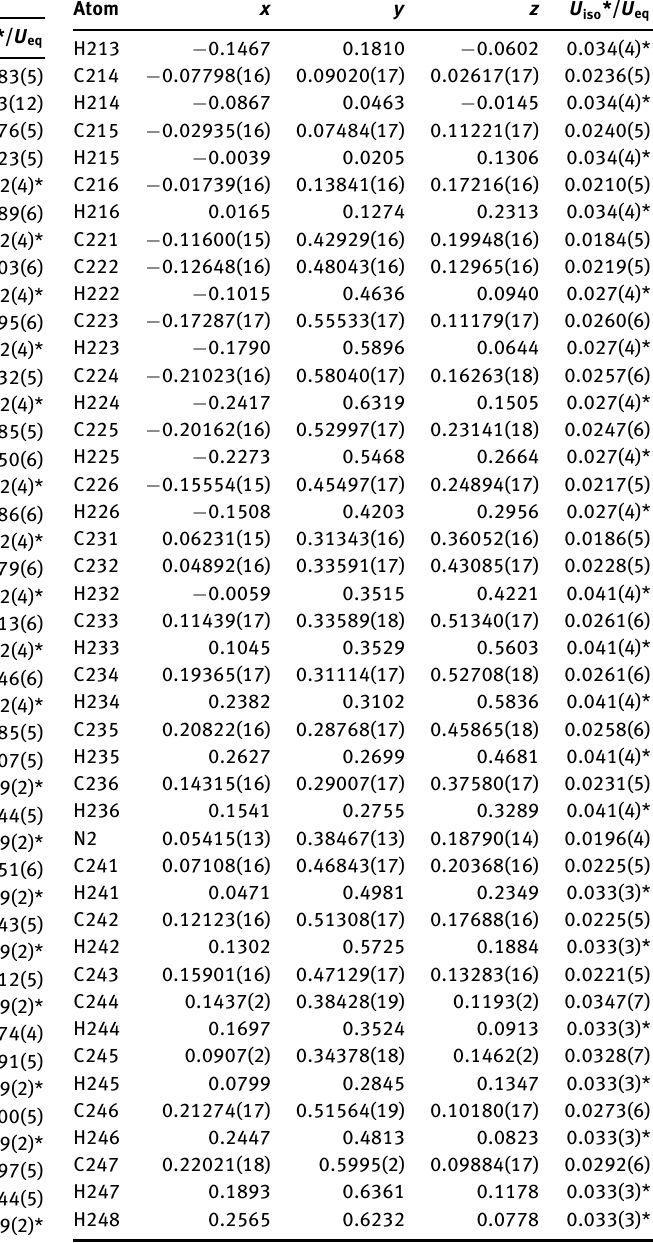
Table 2: Fractional atomic coordinates and isotropic or equivalent isotropic displacement parameters (Å 2